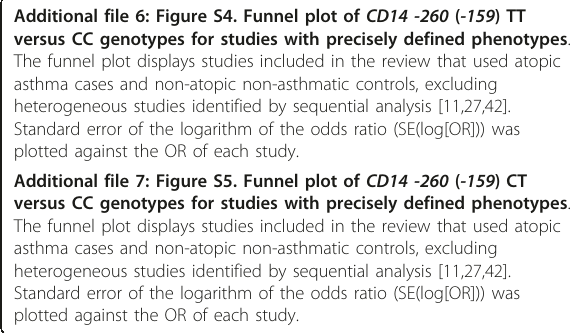
Additional file 6: Figure S4. Funnel plot of CD14 -260 ( -159 ) TT versus CC genotypes for studies with precisely defined phenotypes .